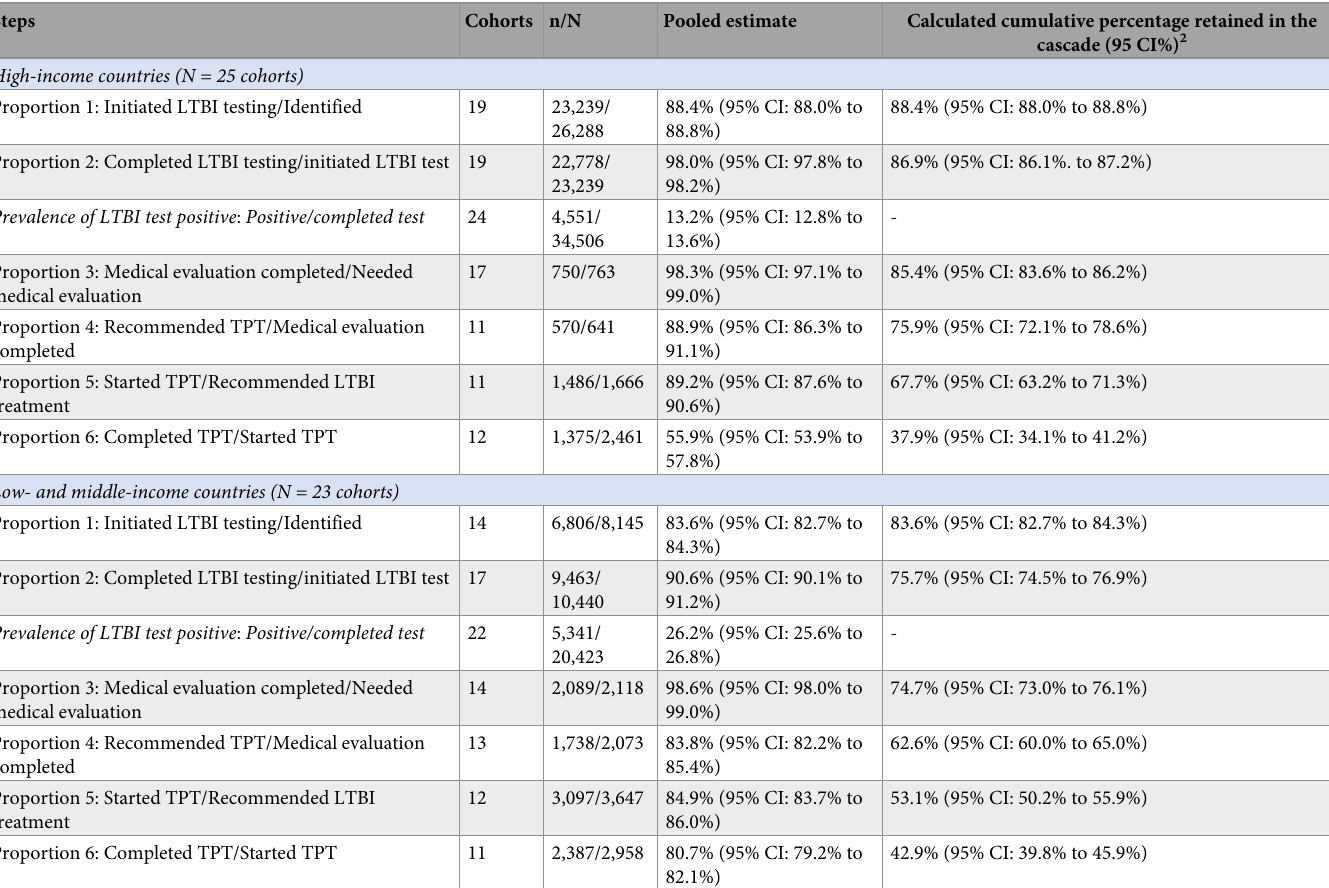
Table 3. Pooled estimate for each step of the cascade in cohorts that used LTBI tests, stratified by country income level 1 (pooled using fixed effect